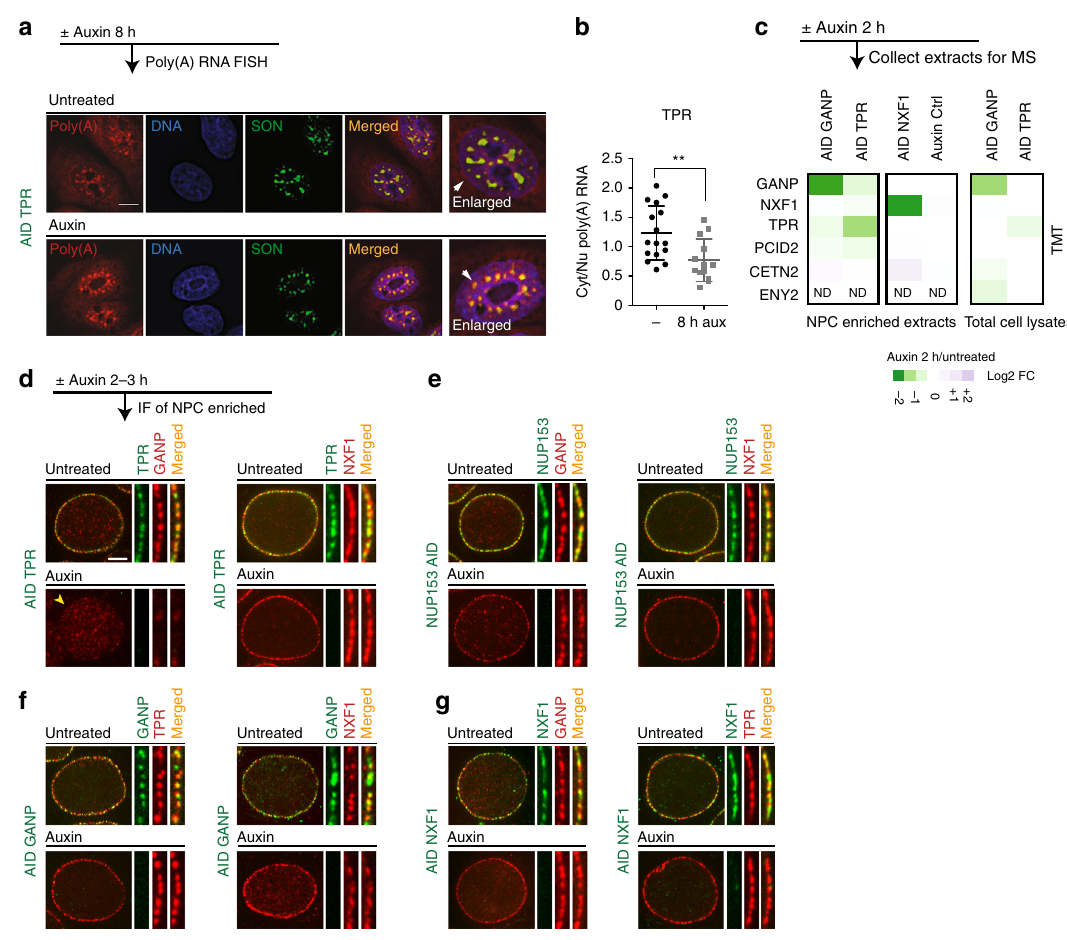
Fig. 3 TPR is required for both GANP localization and ef fi cient export of poly(A) RNA. a The analysis of cytoplasmic – nuclear distribution of poly(A) RNA in AID TPR cells using oligo(dT)-Quasar 670 probe 8 h after TPR degradation. Note that Poly(A) RNA accumulates in the nuclear speckles. Scale bar: 10 µ m. b Quanti fi cation of cytoplasmic-to-nuclear (Cyt/Nu) Poly(A) RNA distribution. Biological triplicates from two independent experiments were used (** p value 0.0062, n = 16 untreated and n = 13 auxin-treated cells, unpaired two-tailed Student ’ s t test). Data are presented as mean values; error bars are SD. c A heat map of differential abundance of the indicated proteins in either NPC-enriched fractions or total lysates upon loss of GANP, TPR, or NXF1, analyzed by TMT-assisted mass spectrometry. Note that the loss of TPR results in diminished abundance of TREX-2 complex subunits (GANP and PCID2) to the NPC but does not affect their total protein amount. Data represent a repeat of one experiment. d – g Targeting of GANP and NXF1 to the NPC. d , e GANP localization at the NE depends on TPR but not on NUP153 or NUP50, while NXF1 localization is not affected upon loss of either BSK-NUPs (see also Supplementary Fig. 7a). f , g GANP and NXF1 localization at the NE are independent of each other. Scale bar: 5 µ m. All BSK-NUPs and NXF1 AID-tagged cell lines were treated with auxin for 2 h; GANP AID-tagged cell line was treated with auxin for 3 h. Data are representative of at least three